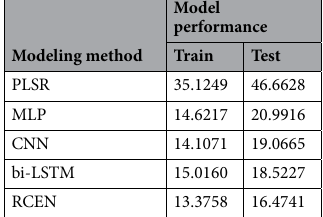
Table 3. Estimation performance of different